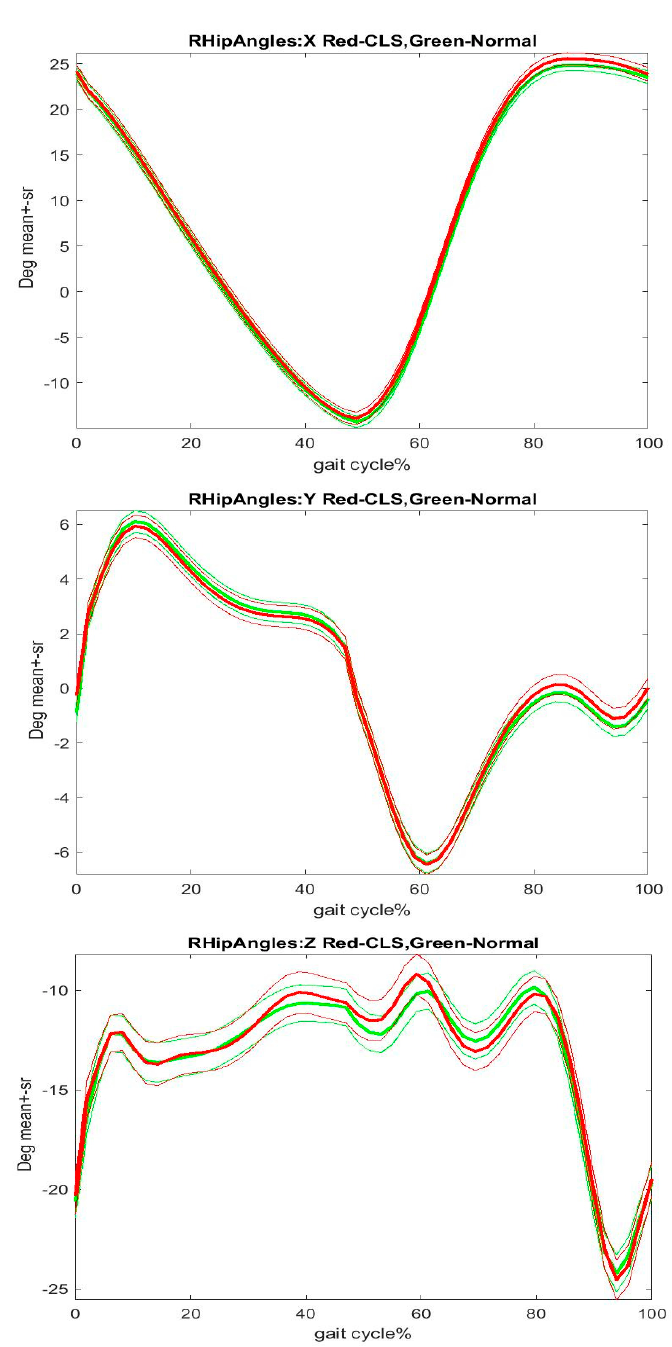
Figure 3. Hip angles’ comparison between before and after CLS in right side. Note: Green: before CLS, Red: after CLS; X, Y, and Z: the sagittal, coronal, and transverse planes. Thickness lines: mean, fined lines: standard error of mean. The curve patterns were plotted using right side 118 pair trials for before and after CLS, and some trails with gaps were removed. As the trails used to plot figures were resampled to 50 frames, there are slightly numeric differences between figures and tables. Nevertheless, the figures show the trends between before and after CLS. Table 3. Hip Joint Angle in sagi tt al, coronal, and transverse planes.